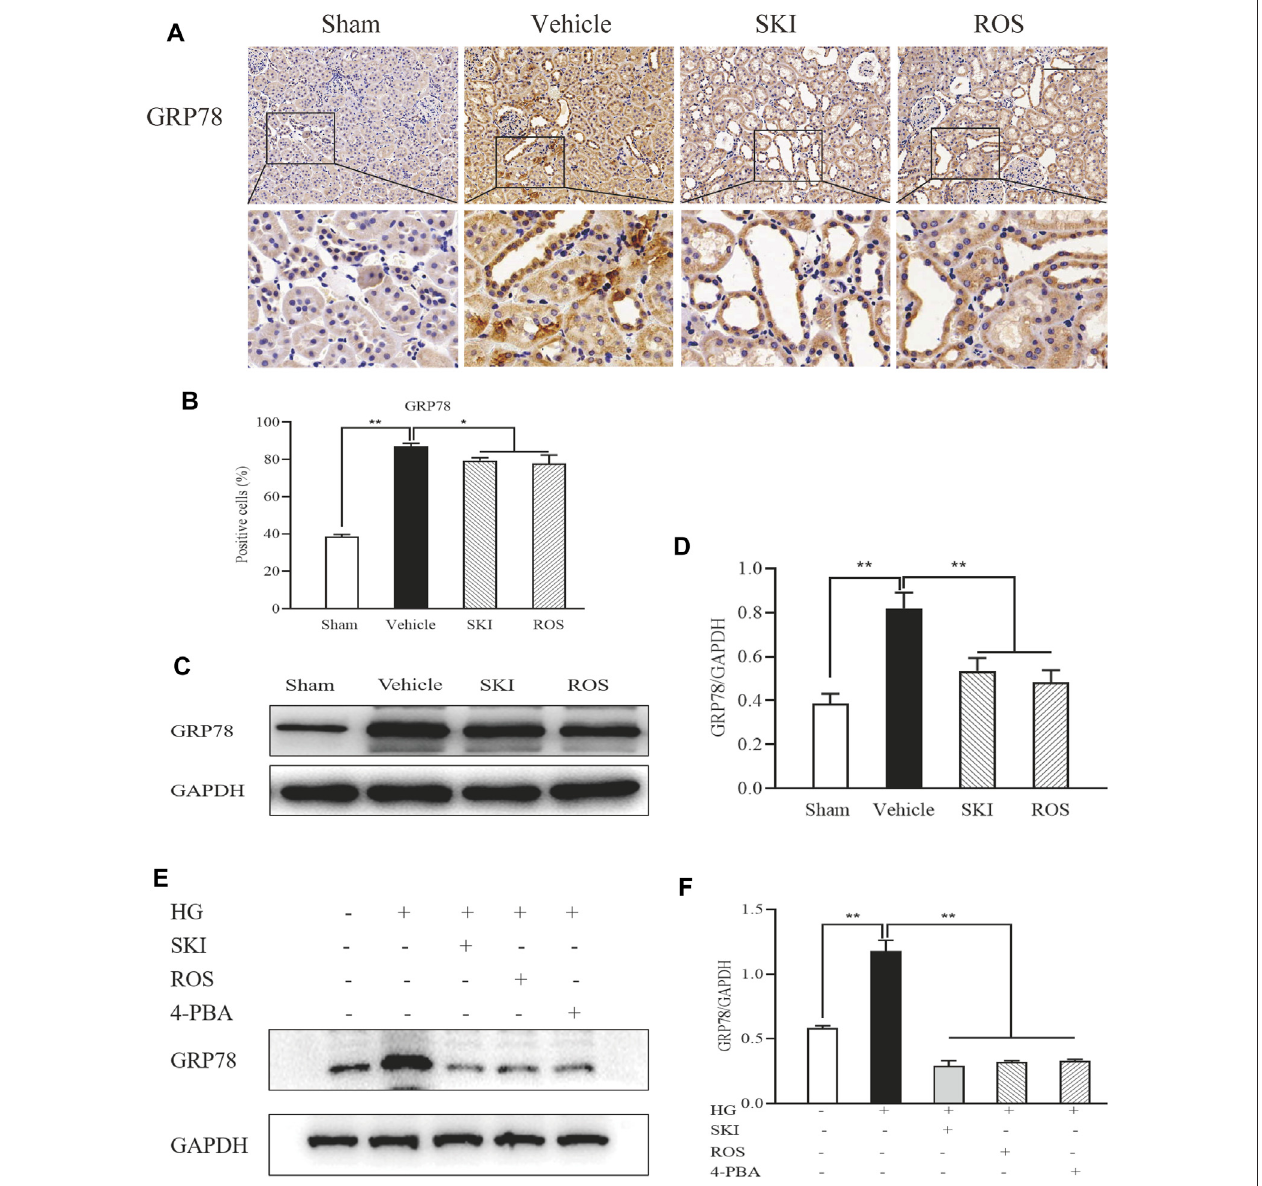
FIGURE11| TheeffectsofSKIandROSontheexpressionlevelsofGRP78 invivo and invitro . (A) ImmunostainingofGRP78inthekidney( × 200); (B) Thenumber ofpositivelystainedcells; (C) WBanalysisofGRP78 inthekidney; (D) TherateofGRP78 toGAPDH; (E) WB analysisofGRP78inNRK-52Ecells exposedtoHGand4- PBAwithorwithoutSKIorROSfor24 h. (F) TherateofGRP78toGAPDH.Scalebar (cid:2) 100 μ m.Dataareexpressedasmean ± S.E.* p < 0.05,** p < 0.01.Abbreviations: GRP78, glucose-regulated protein 78; WB, Western blot; GAPDH, glyceraldehyde-3-phosphate dehydrogenase; HG, high glucose; 4-PBA, 4-phenylbutyric acid; ROS, rosiglitazone; SKI, Shenkang